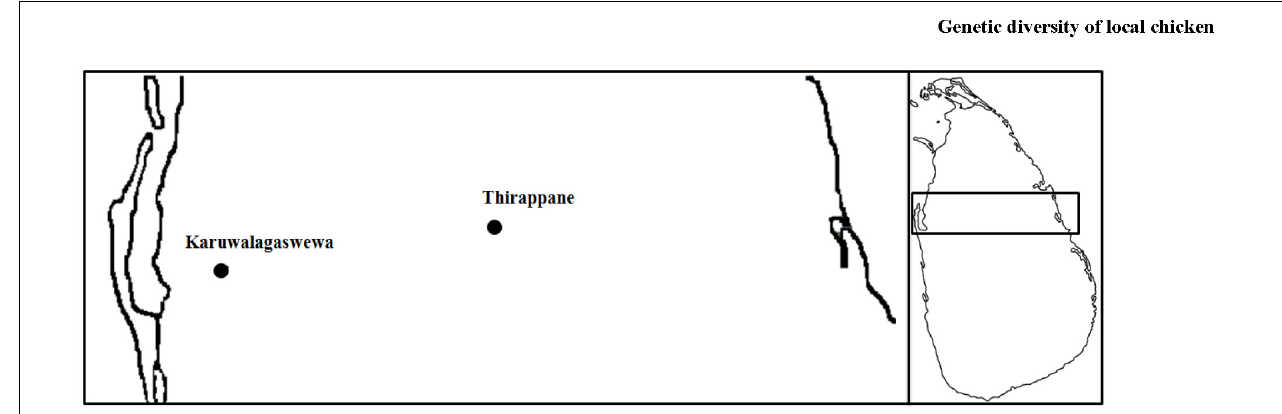
FIGURE 1 | The Sri Lankan map showing the two sampling locations, Thirappane and Karuwalagaswewa. TABLE 1 | The number of village chicken ecotypes selected from each household of the five villages in two sites (Thirappane and Karuwalagaswewa) for genotyping analysis. Site Village Village